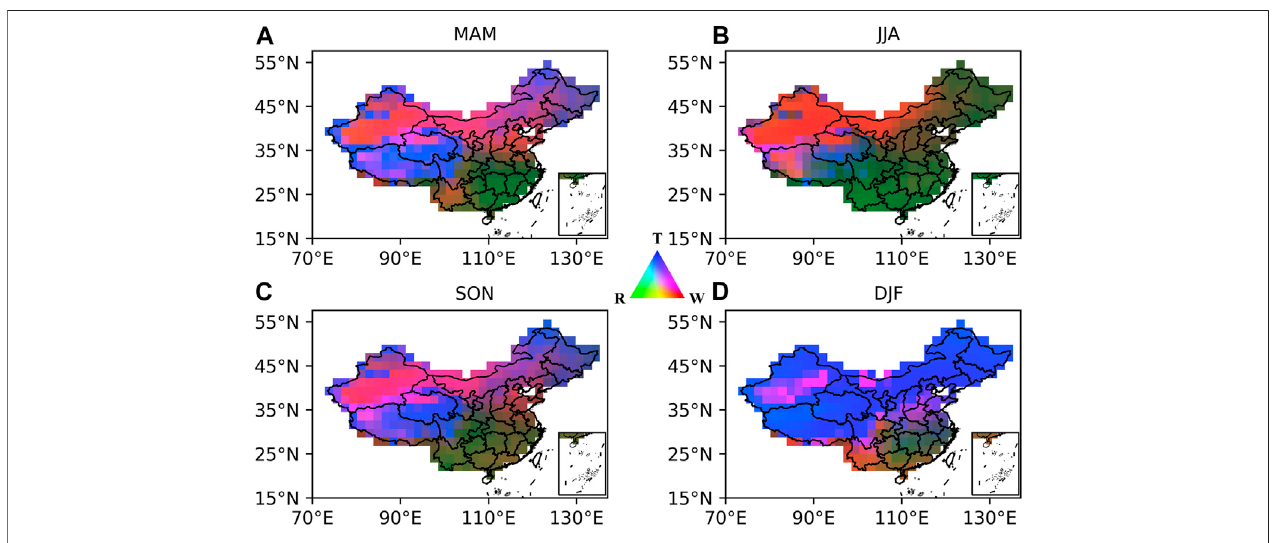
FIGURE 2 | Geographic distribution of potential climatic constraints to plant growth derived from long-term (2000 – 2019) climate statistics in (A) spring, (B) summer, (C) autumn, and (D) winter. R, T, and W represent radiation, temperature, and water resources, respectively. Deeper green indicates stronger constraints of radiation on GPP, deeper blue indicates stronger constraints of temperature on GPP, and deeper red indicates stronger constraints of water on GPP.